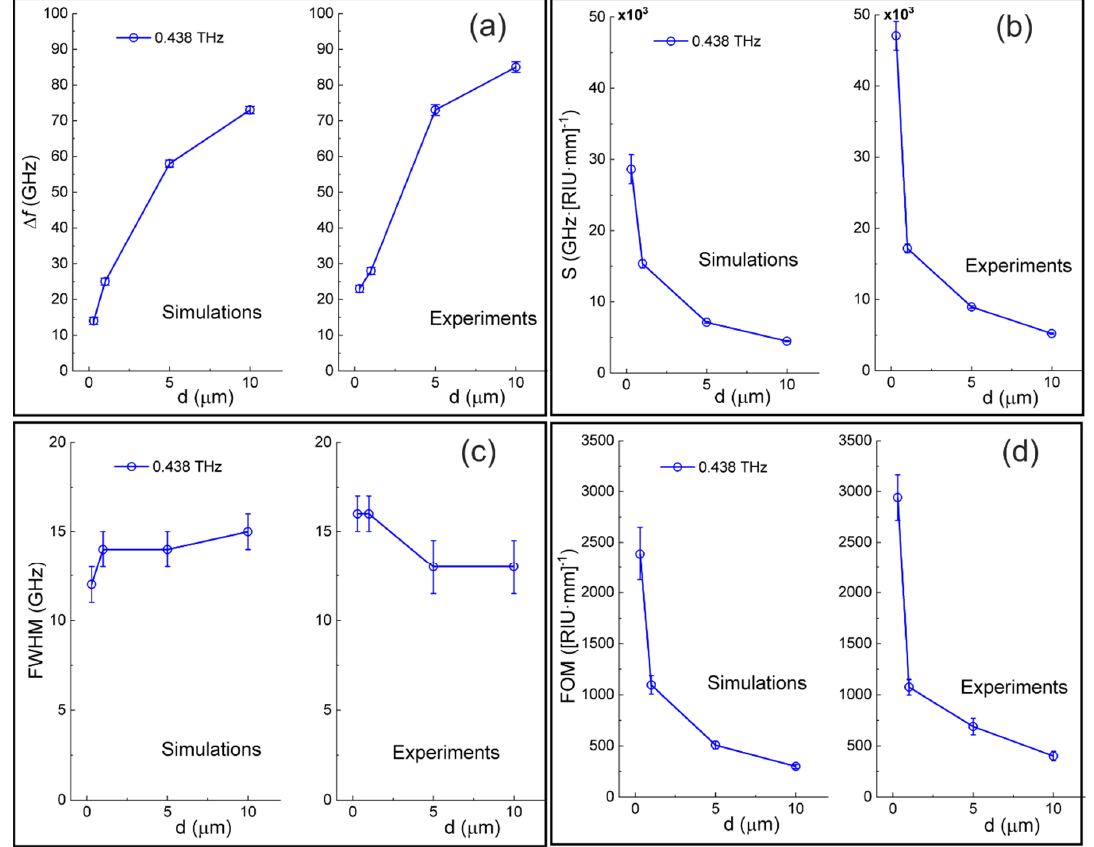
Figure 7. Sensor parameters for the closely spaced ( p = 408 µ m) spiral disks with centers shifted by δ r = 35 µ m, evaluated from the transmittance spectra in Figure 7: ( a ) the frequency shift ∆ f of resonance at 0.438 THz vs. the photoresist thicknesses d (left—simulations, right—experiments); ( b ) the sensitivity S vs. d ; ( c ) FWHM vs. d ; ( d ) FOM vs. d .